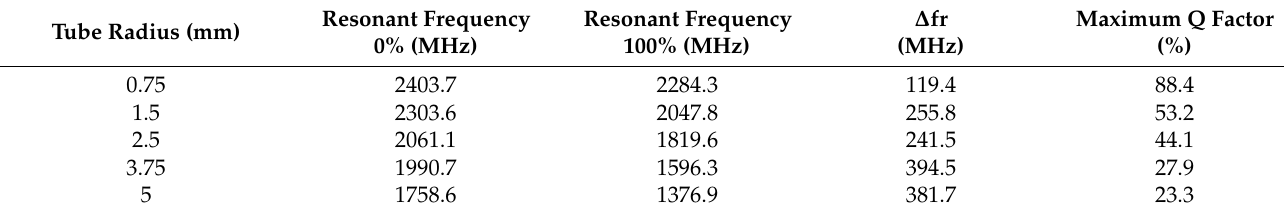
Table 3. Sensitivity for different tube radius.